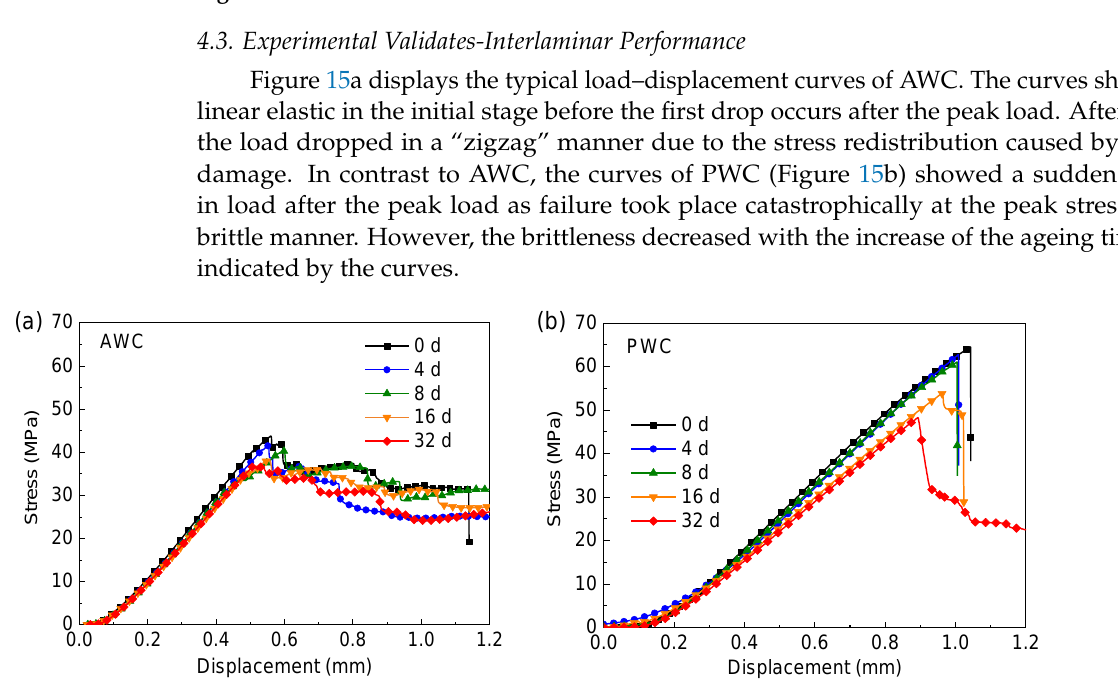
Figure 14. Distribution of interface cracks in AWC and PWC.